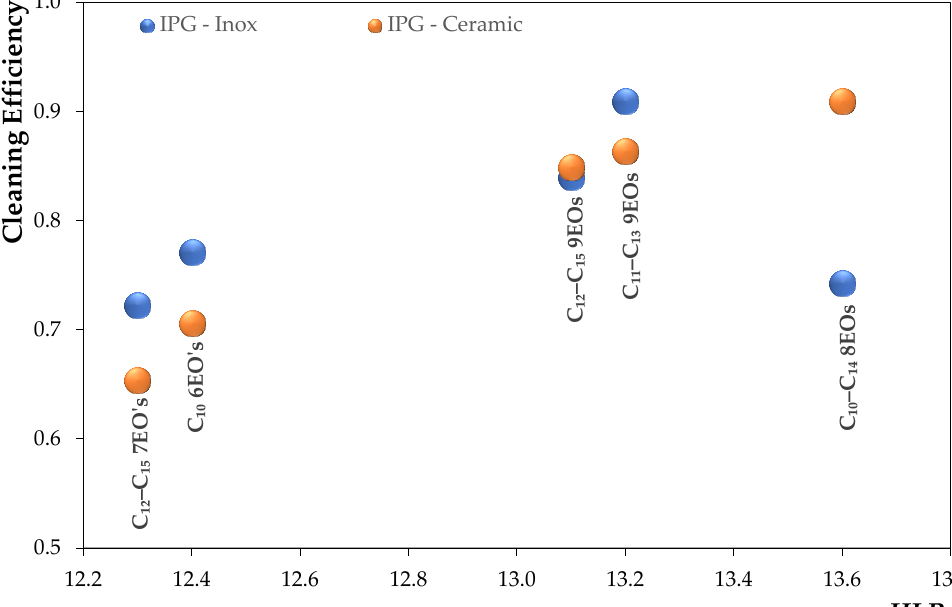
Figure 5. Cleaning efficiency vs. HLB of formulations with IPG as solvent and nonionic surfactants on both surfaces: ceramic and stainless steel.